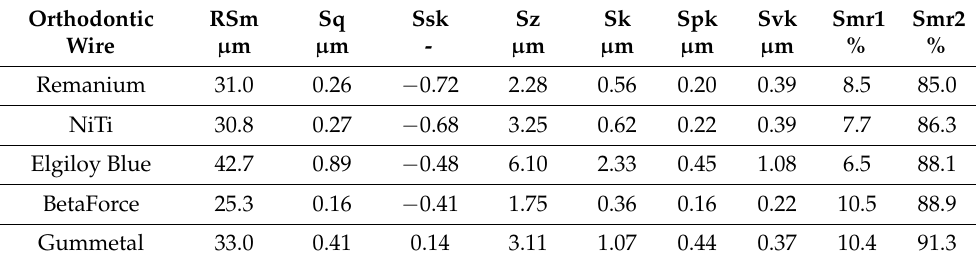
Table 7. Surface parameters for wires made from different